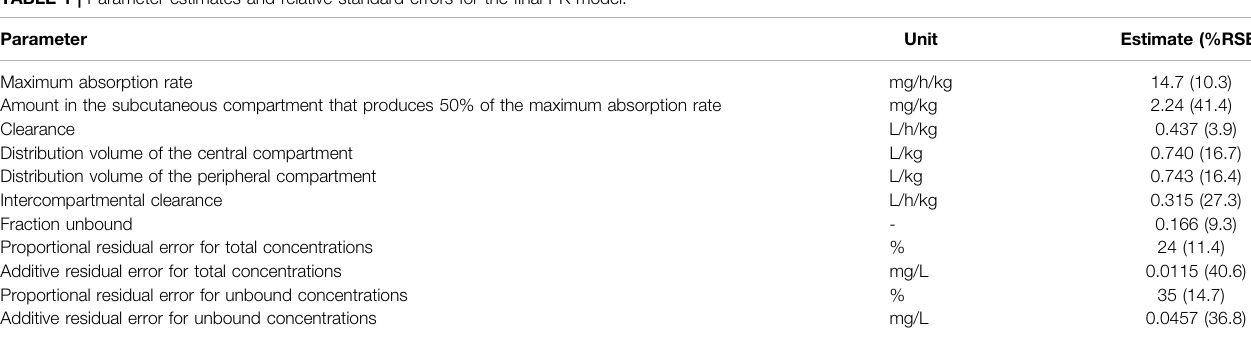
TABLE 1 | Parameter estimates and relative standard errors for the fi nal PK model. Parameter Maximum absorption